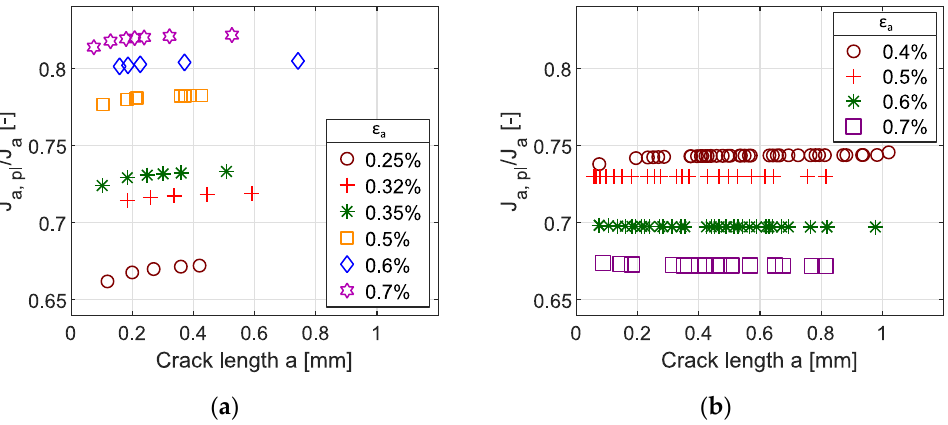
Figure 16. Ratio between plastic part of J-integral and J-integral vs. crack length in ( a ) Sanicro 25 and ( b )